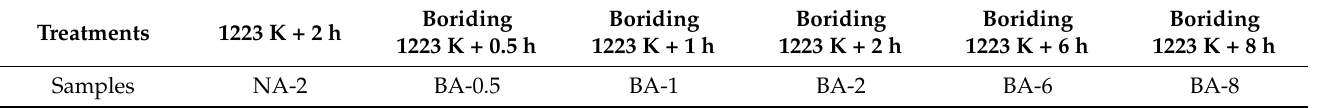
Figure 1. Schematic experimental procedures: ( a ) boro-austempering treatment; ( b ) merely austem- Figure 1. Schematicexperimentalprocedures: ( a )boro-austemperingtreatment; ( b )merelyaustempering. pering. Table 1. The represented symbols of samples with different Table 1. The represented symbols of samples with different treatments.